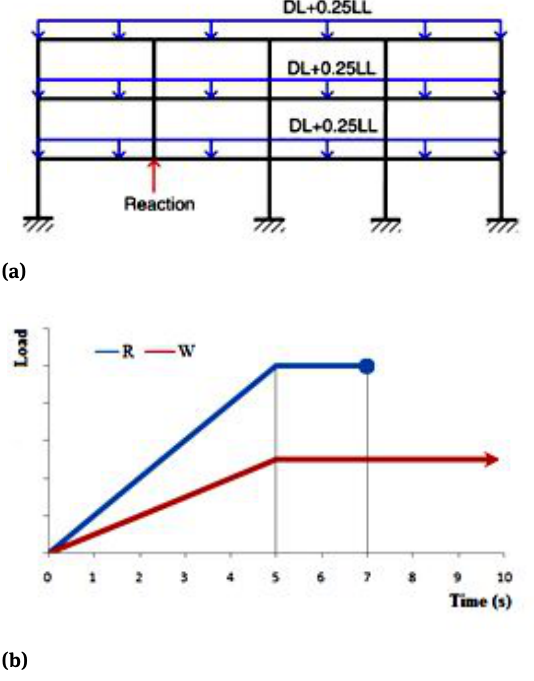
Figure 3: Nonlinear Dynamic Analysis (NDA) according to the Gen- eral Services Administration (GSA) Standard (GSA (2003)), (a) Load Pattern; (b) Time History of Gravity